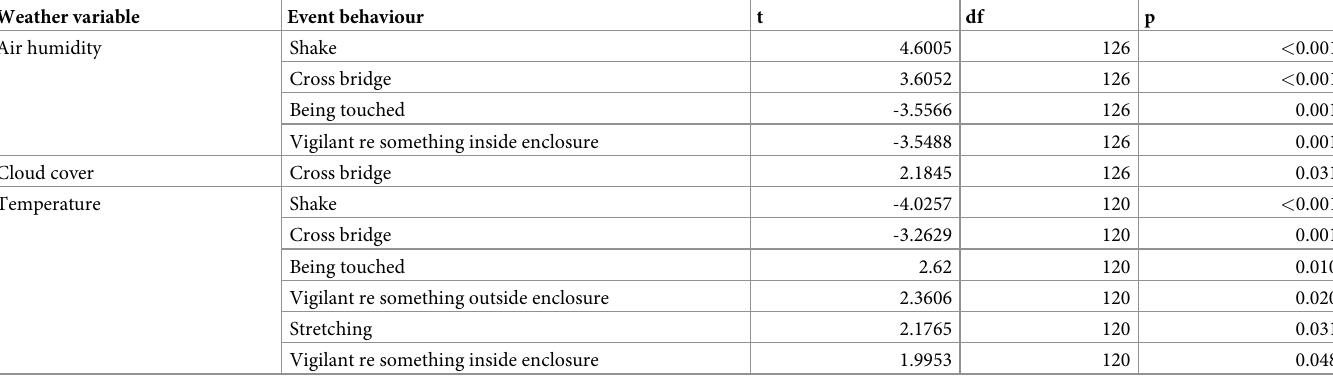
Table 3. Results of the Pearson’s correlation test between weather variables and event behaviours that were significantly related to wearing the collar. Weather